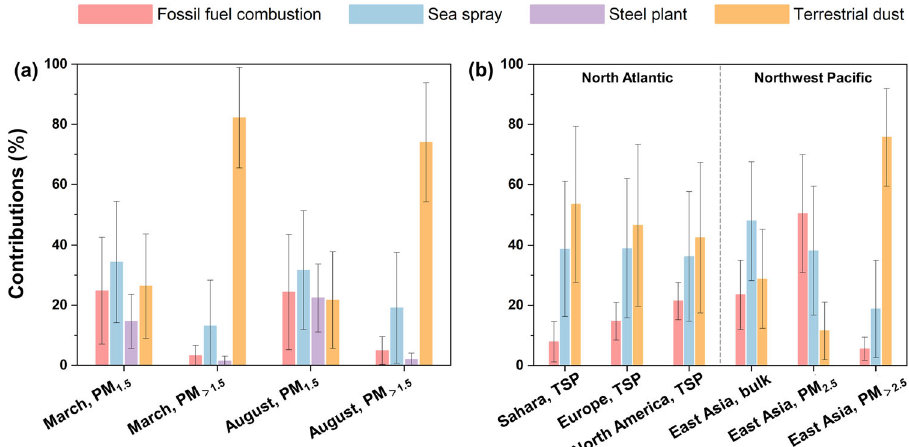
Fig. 3 Iron source apportionment results (mean ± standard deviation) based on model calculations with iron isotope ratios of different size particles from urban and marine aerosols. Source apportionment results in a Hiroshima, b North Atlantic and Northwest Paci fi c. Marine aerosols are classi fi ed according to the dominant impact of air masses 71,152 . For the Northwest Paci fi c, bulk particles are referred to coarse (PM >2.5 ) + fi ne (PM 2.5 ) fractions. Original data of Hiroshima, Northwest Paci fi c and North Atlantic is from Kurisu et al. 148,152 . and Conway et al. 71 , respectively. See Supplementary Tables 4 – 6 for model calculation uncertainties of the